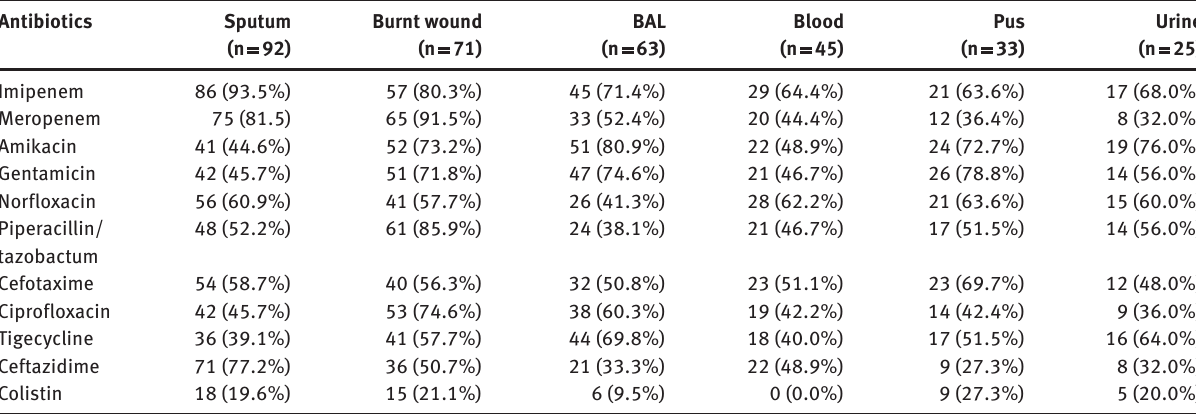
Table 4: Phenotypic detection of MBL-producing P.